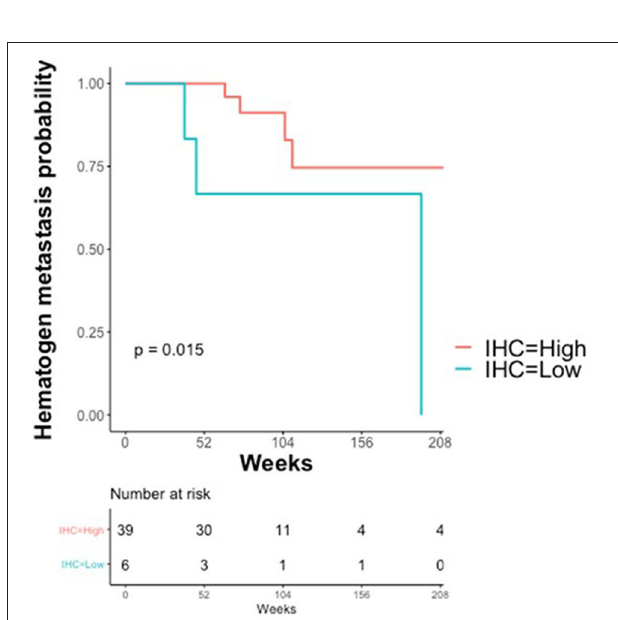
FIGURE 4 | Kaplan–Meier Curves. Kaplan-Meier curves are used to display the relationship between claudin-7 immunohistochemistry score (IHC) and probability of hematogenous metastasis in relapsing patients ( N = 45). IHC was dichotomized (High vs. Low) using Maximally Selected log-rank statistics.